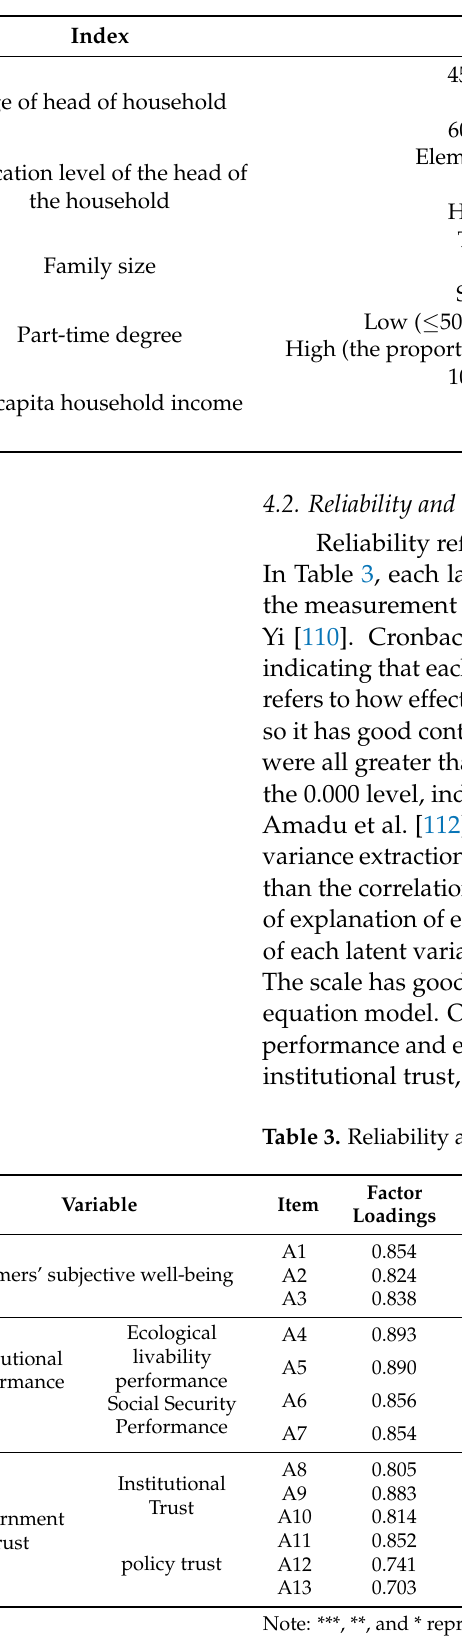
Table 2. Statistics of essential characteristics of sample farmers.